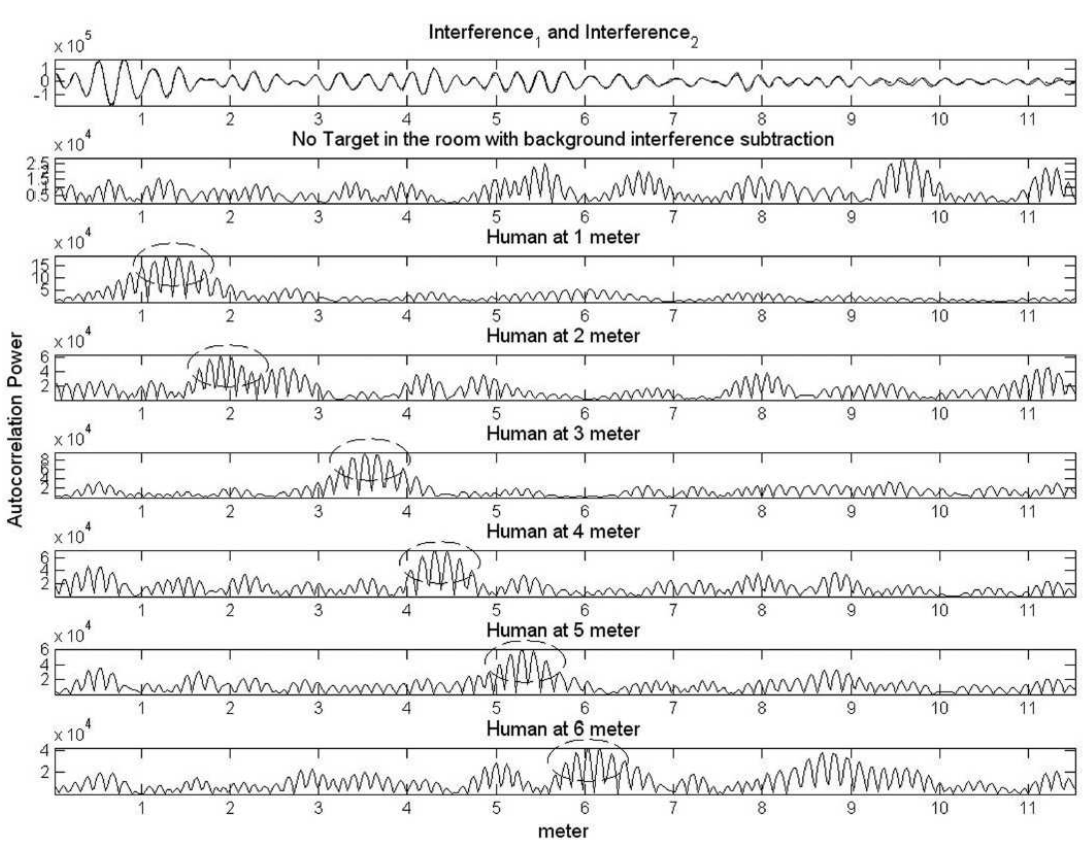
Figure 17. Detecting human movement through a wall using a digital random noise UWB radar sensor [127].